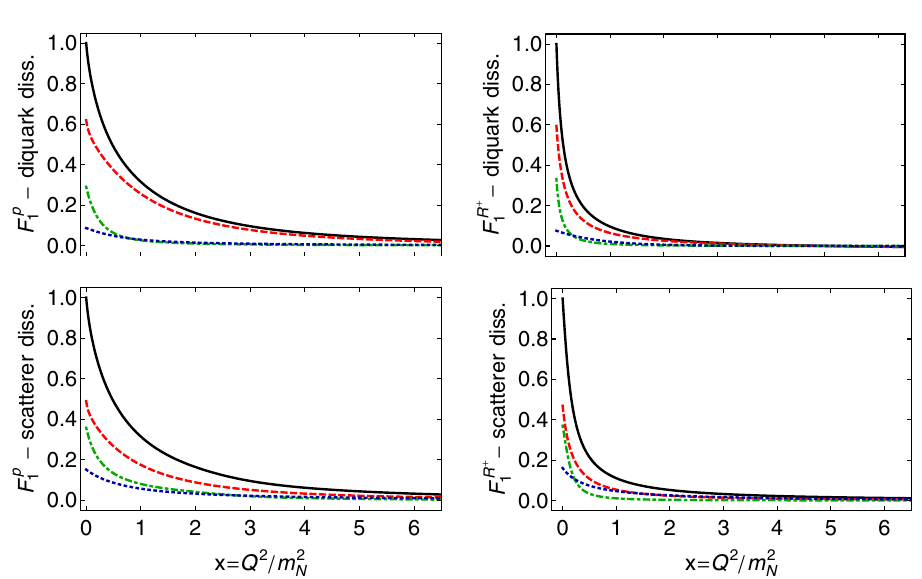
Figure 4. Dirac form factors of the proton (left) and charged-Roper (right). Upper panels – diquark breakdown: DD1 (dashed red), scalar diquark in initial and final baryon; DD2 (dot-dashed green), pseudovector diquark in both initial and final states; DD3 (dotted blue), scalar diquark in incoming baryon, pseudovector diquark in outgoing baryon, and vice versa. Lower panels – scatterer breakdown: DS1 (red dashed), photon strikes an uncorrelated dressed quark; DS2 (dot-dashed green), photon strikes a diquark; and DS3 (dotted blue), diquark breakup contributions, including photon striking exchanged dressed-quark.